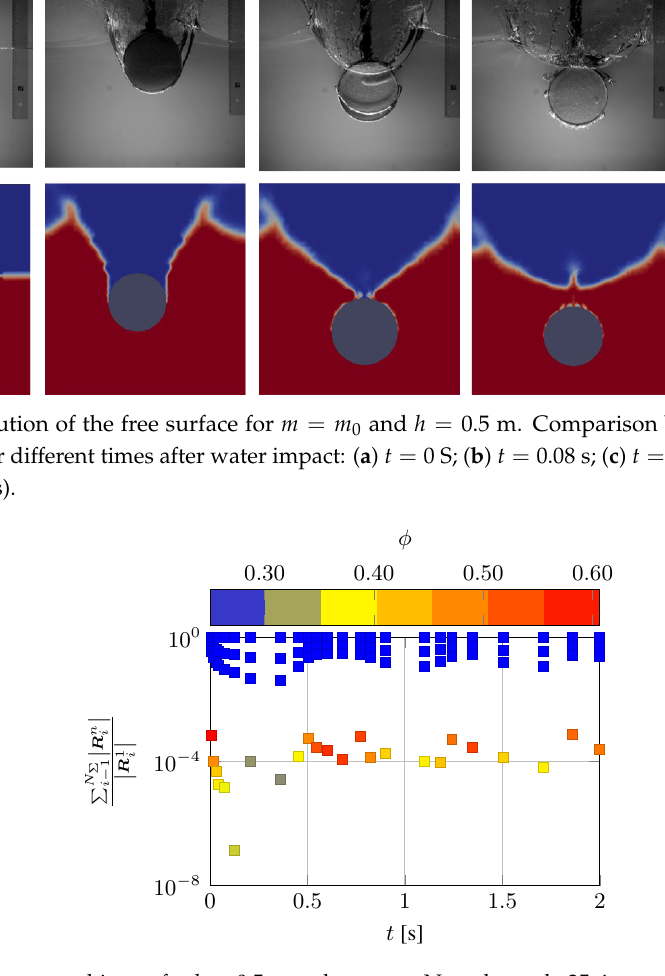
Figure 10. Convergence history for h = 0.5 m and m = m 0 . Note that only 25 time-steps are represented for clarity. Each mark represents a FSI